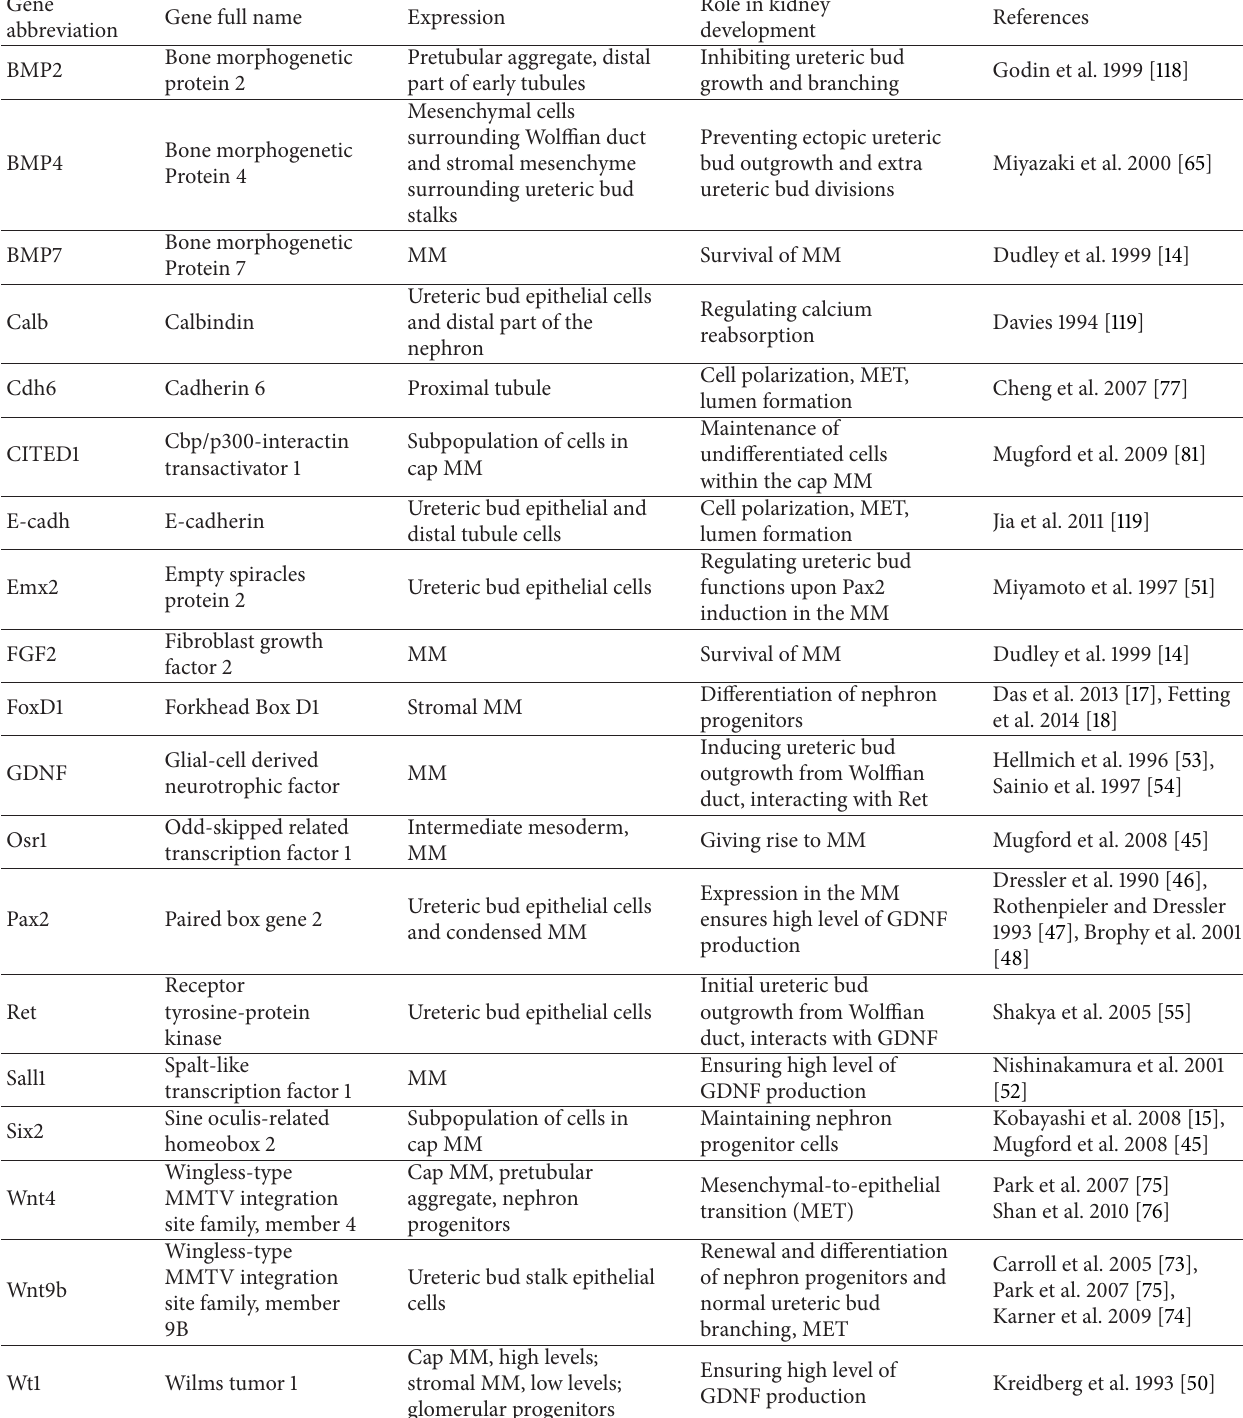
Table 2: Genes important for